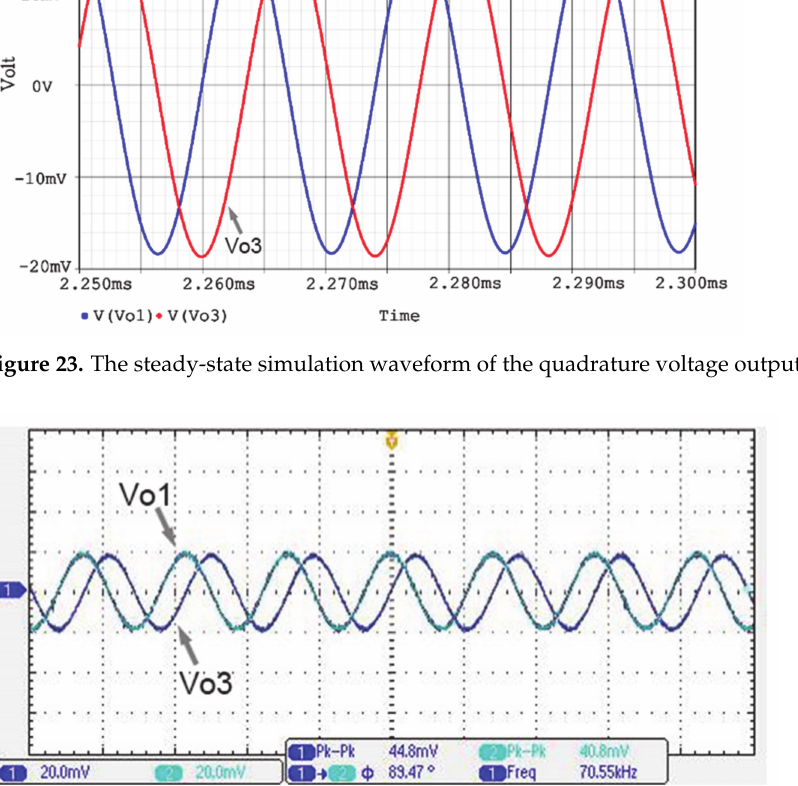
Figure 24. Measured result of quadrature voltage